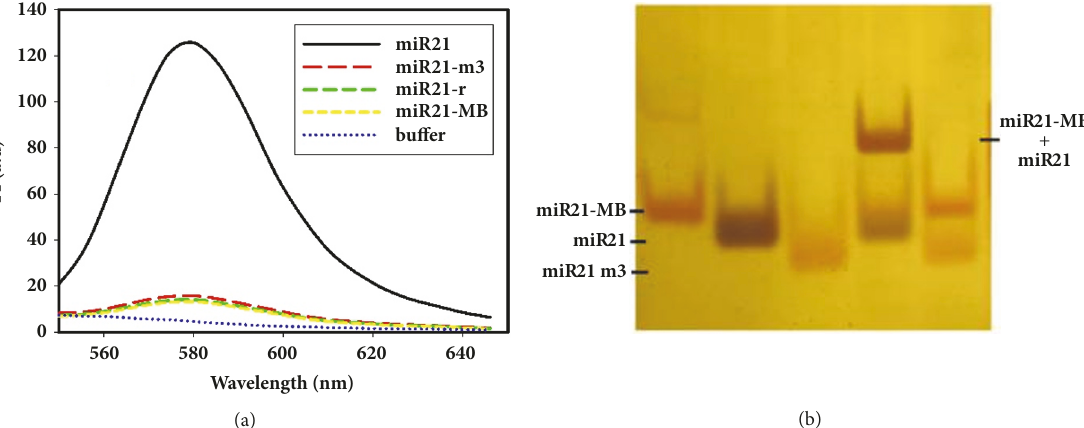
Figure 3: The specificity assay of MB with target by fluorescence spectrometry (a) and polyacrylamide gel electrophoresis staining by silver